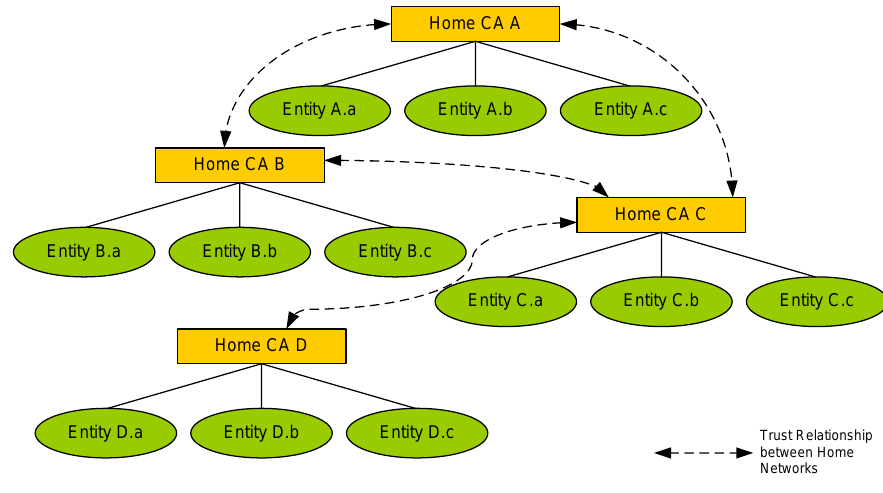
Figure 2. Home Networks use self-certified Home Certificates. After a key exchange—the exchange of home certificates between ‘befriended’ home networks—foreign home networks and entities within can authenticate to each